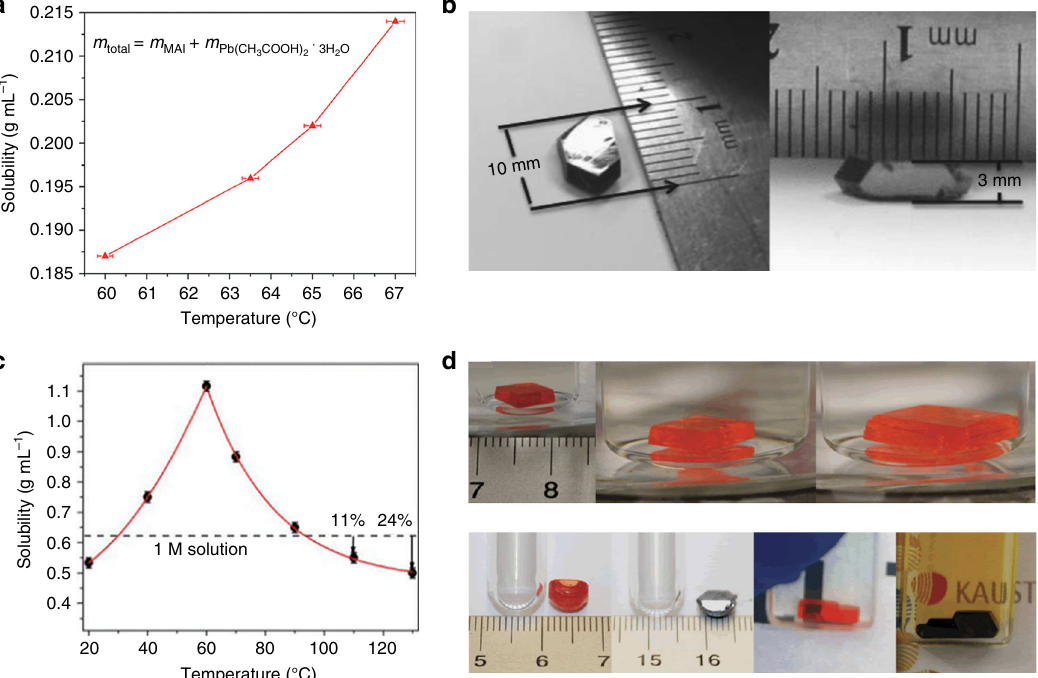
Fig. 2 Perovskite single crystals growth. a Solubility of MAPbI 3 perovskite versus temperature in HI acid. b Photos of as-grown single crystal by top-seeded solution growth method. c Reverse solubility of MAPbI 3 perovskite versus temperature in γ -butyrolactone (GBL). d Photos of as-grown halide perovskite single crystal by inverse temperature method. a is adapted with permission from ref. 57 , RSC Publishing. b is adapted with permission from ref. 43 , AAAS. c is adapted with permission from ref. 58 , American Institute of Physics. d is adapted with permission from ref. 59 , Springer